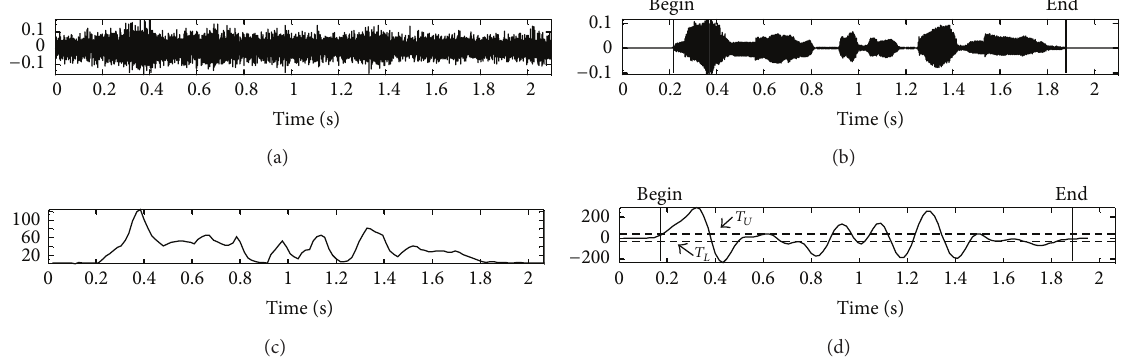
Figure 7: Results of the proposed algorithm in a car - noise environment: (a) noisy speech signal at SNR − 5 dB, (b) clean speech signal, (c) the proposed feature, and (d) edge detection filter output based on the proposed feature.